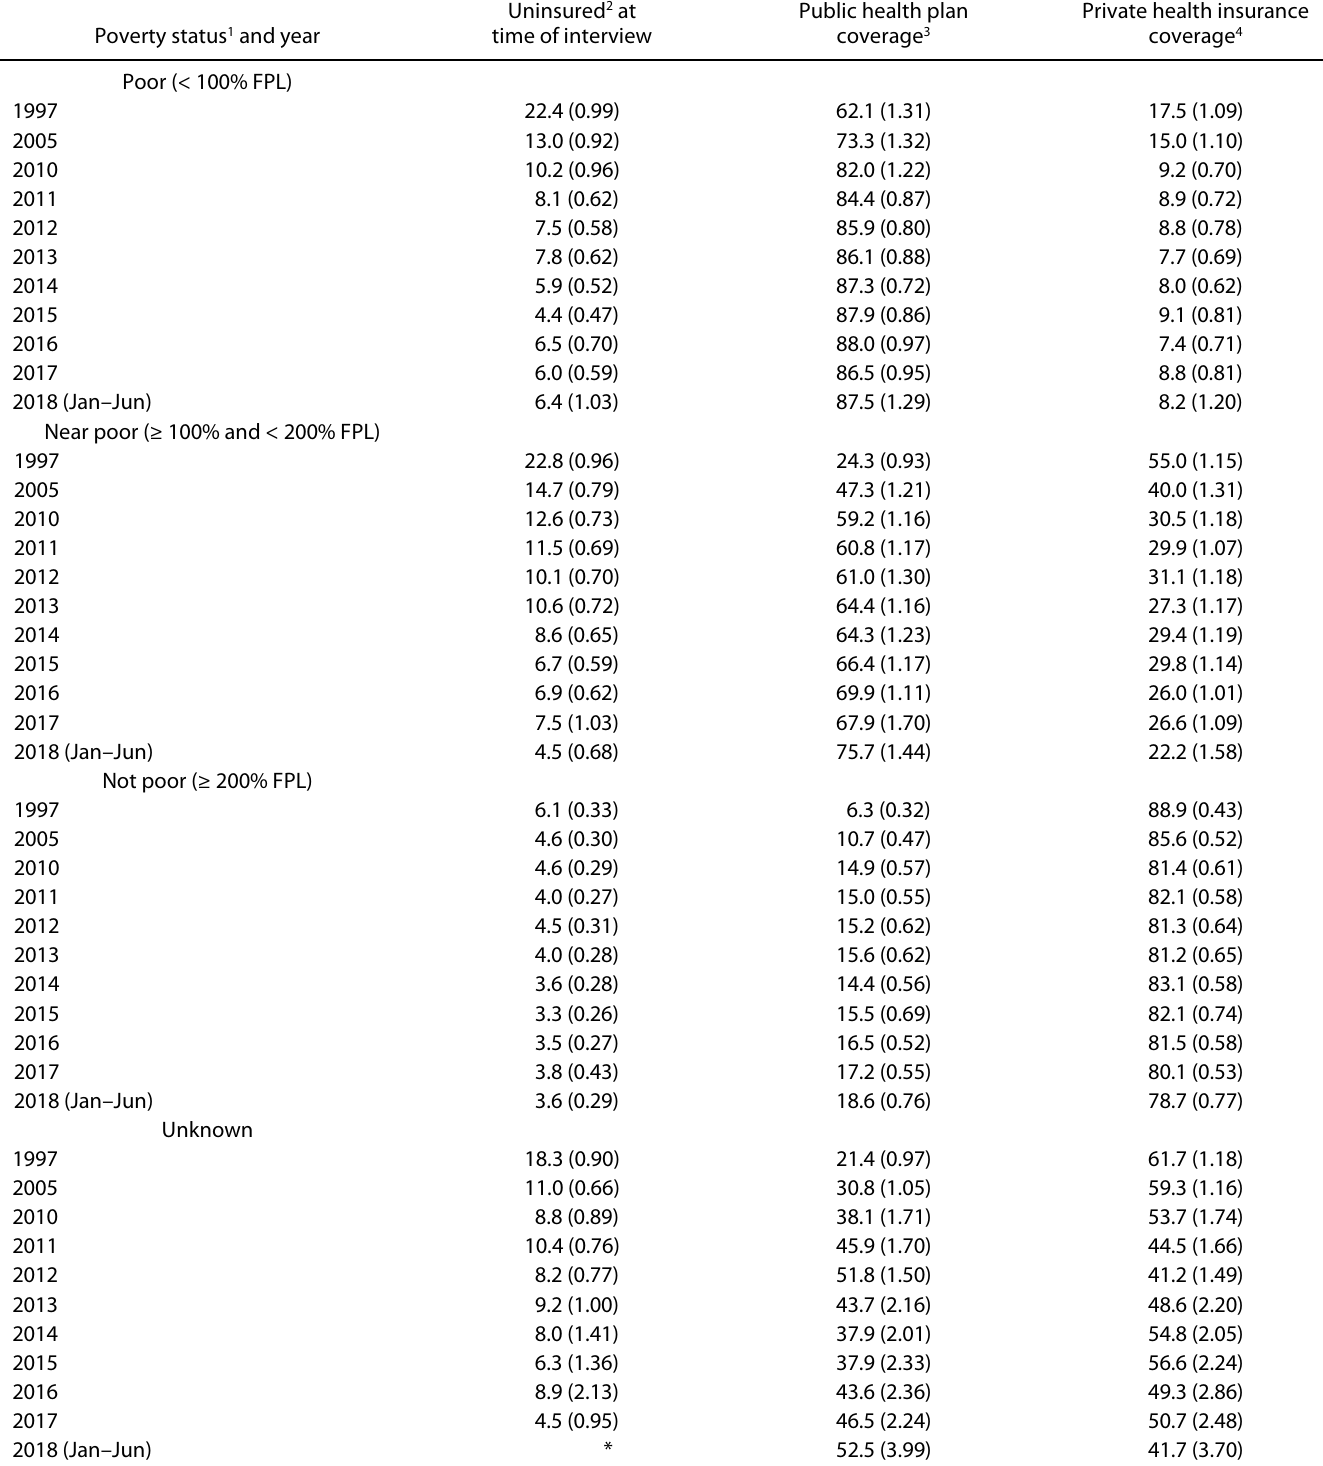
Table VI. Percentages (and standard errors) of children aged 0–17 years who lacked health insurance coverage, had public health plan coverage, and had private health insurance coverage at the time of interview, by poverty status and selected